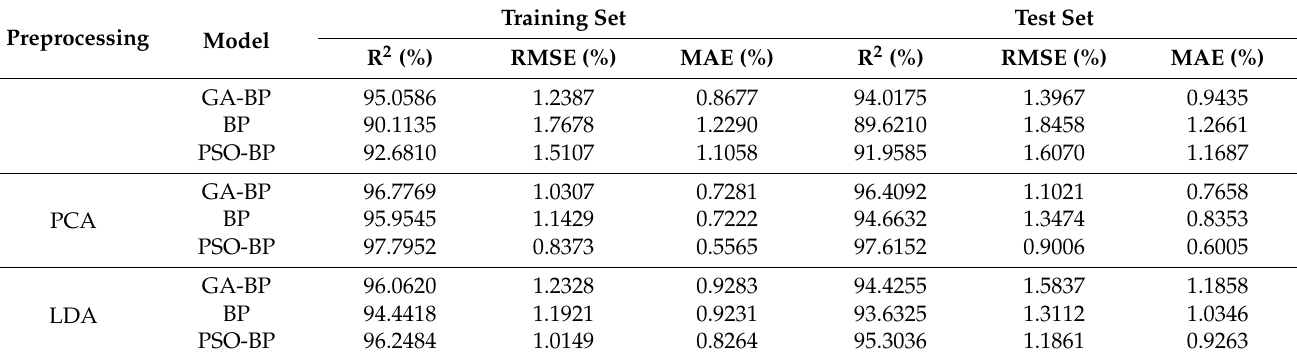
Table 3. Predictions from different